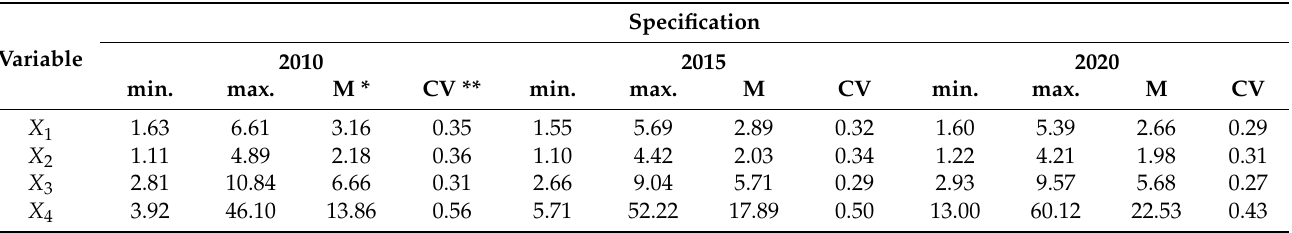
Table 5. Numerical characteristics of sustainable energy development indicators in specific